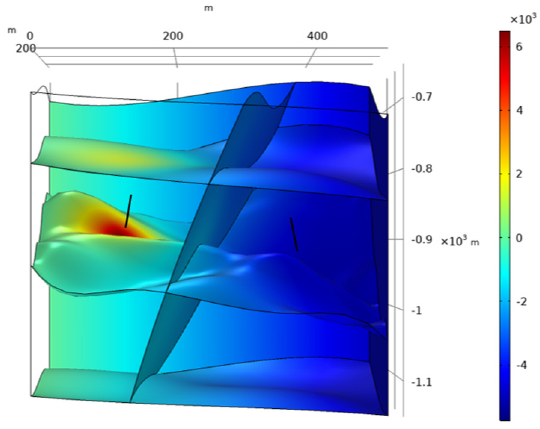
Figure 3. Pressure distribution after 10 years of simulation.